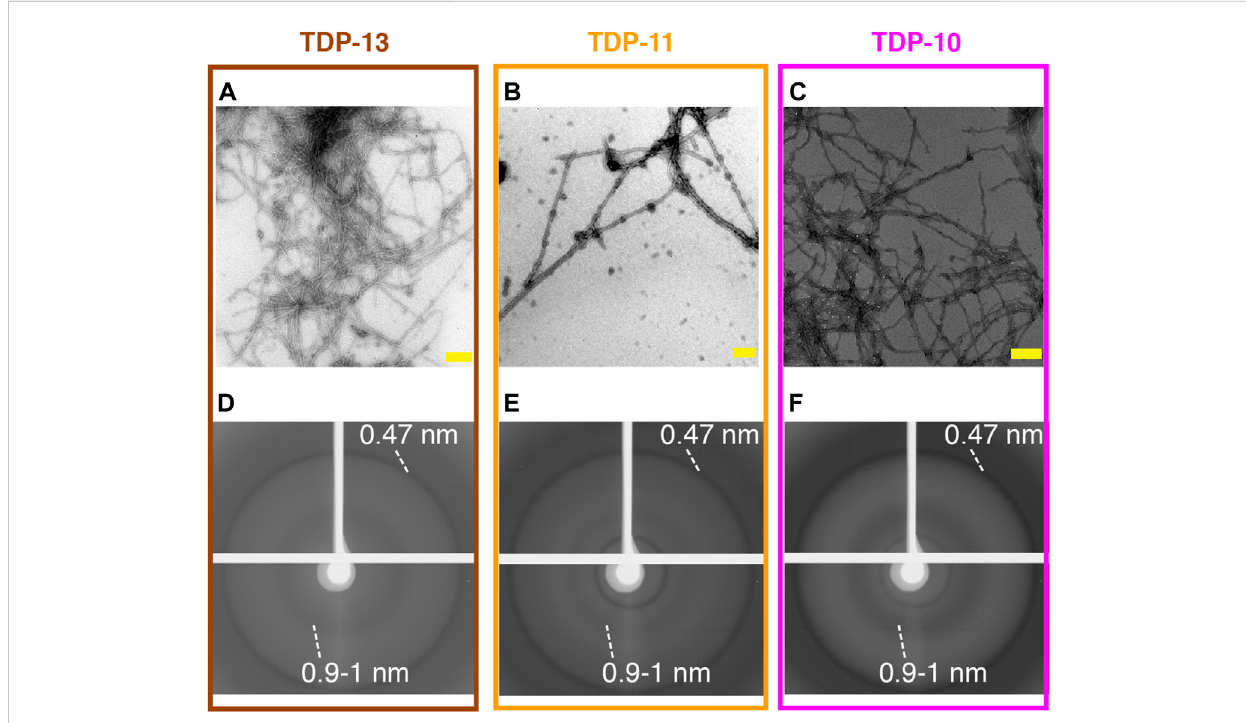
FIGURE 2 Structural analysis of low complexity CTFs aggregates. (A – C) Negatively stained electron micrographs of TDP-13 (A) , TDP-11 (B) , and TDP-10 (C) aggregates. Scale bars (in yellow) are 200 nm. (D – F) X-ray diffraction patterns of TDP-13 (D) , TDP-11 (E) , and TDP-10 (F) aggregate display characteristic cross- β re fl ections. Re fl ections at 4.7 Å and 9 – 10 Å are